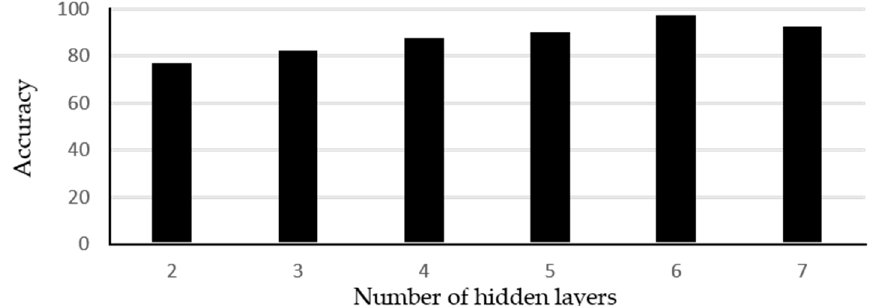
Figure 9. Accuracy as function of number of hidden layers in CNN.